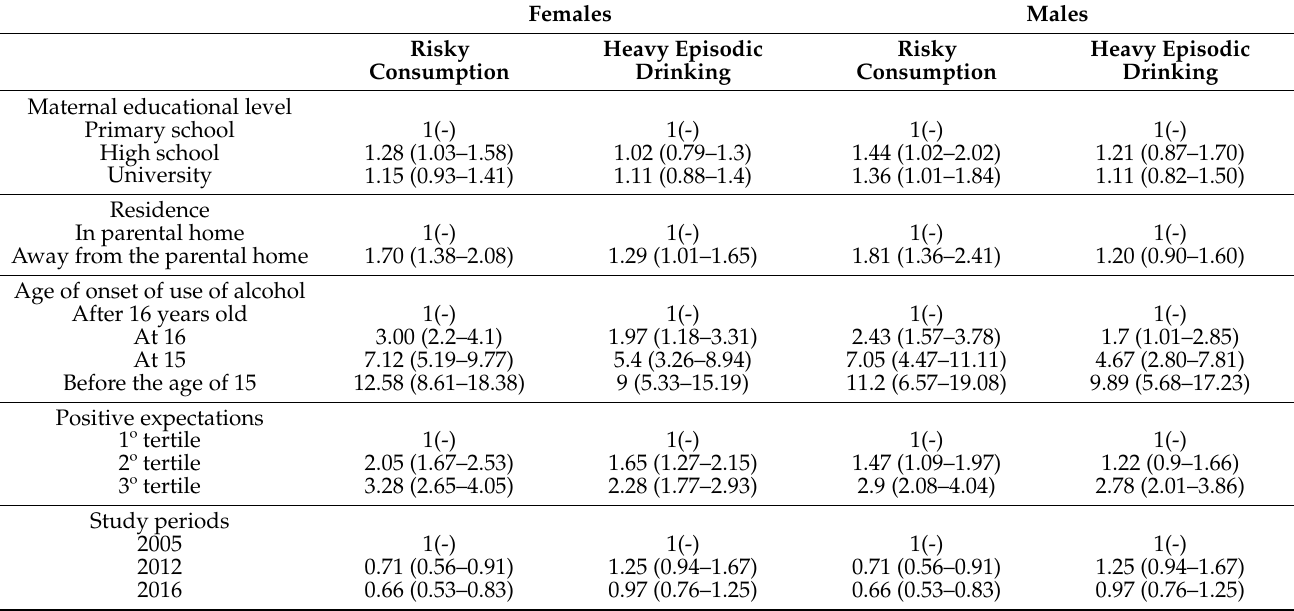
Table 6. Influence of explanatory factors on Risky consumption and Heavy episodic drinking among all male and female students recruited in 2005, 2012 and 2016. Results are presented as adjusted odds ratio (95%CI) a